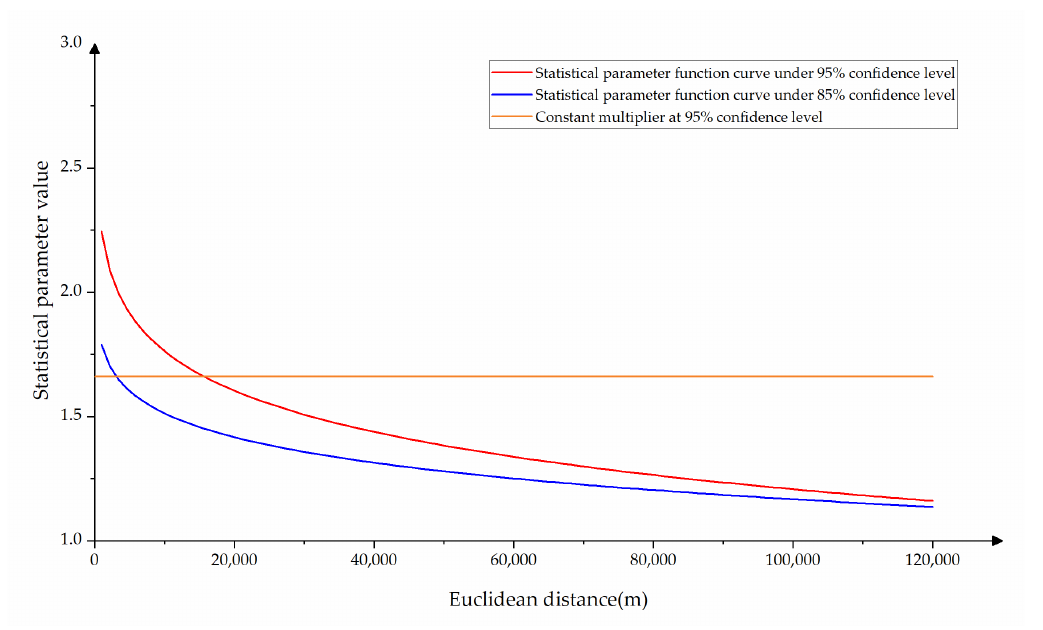
Figure 4. Statistical parameter function graph.